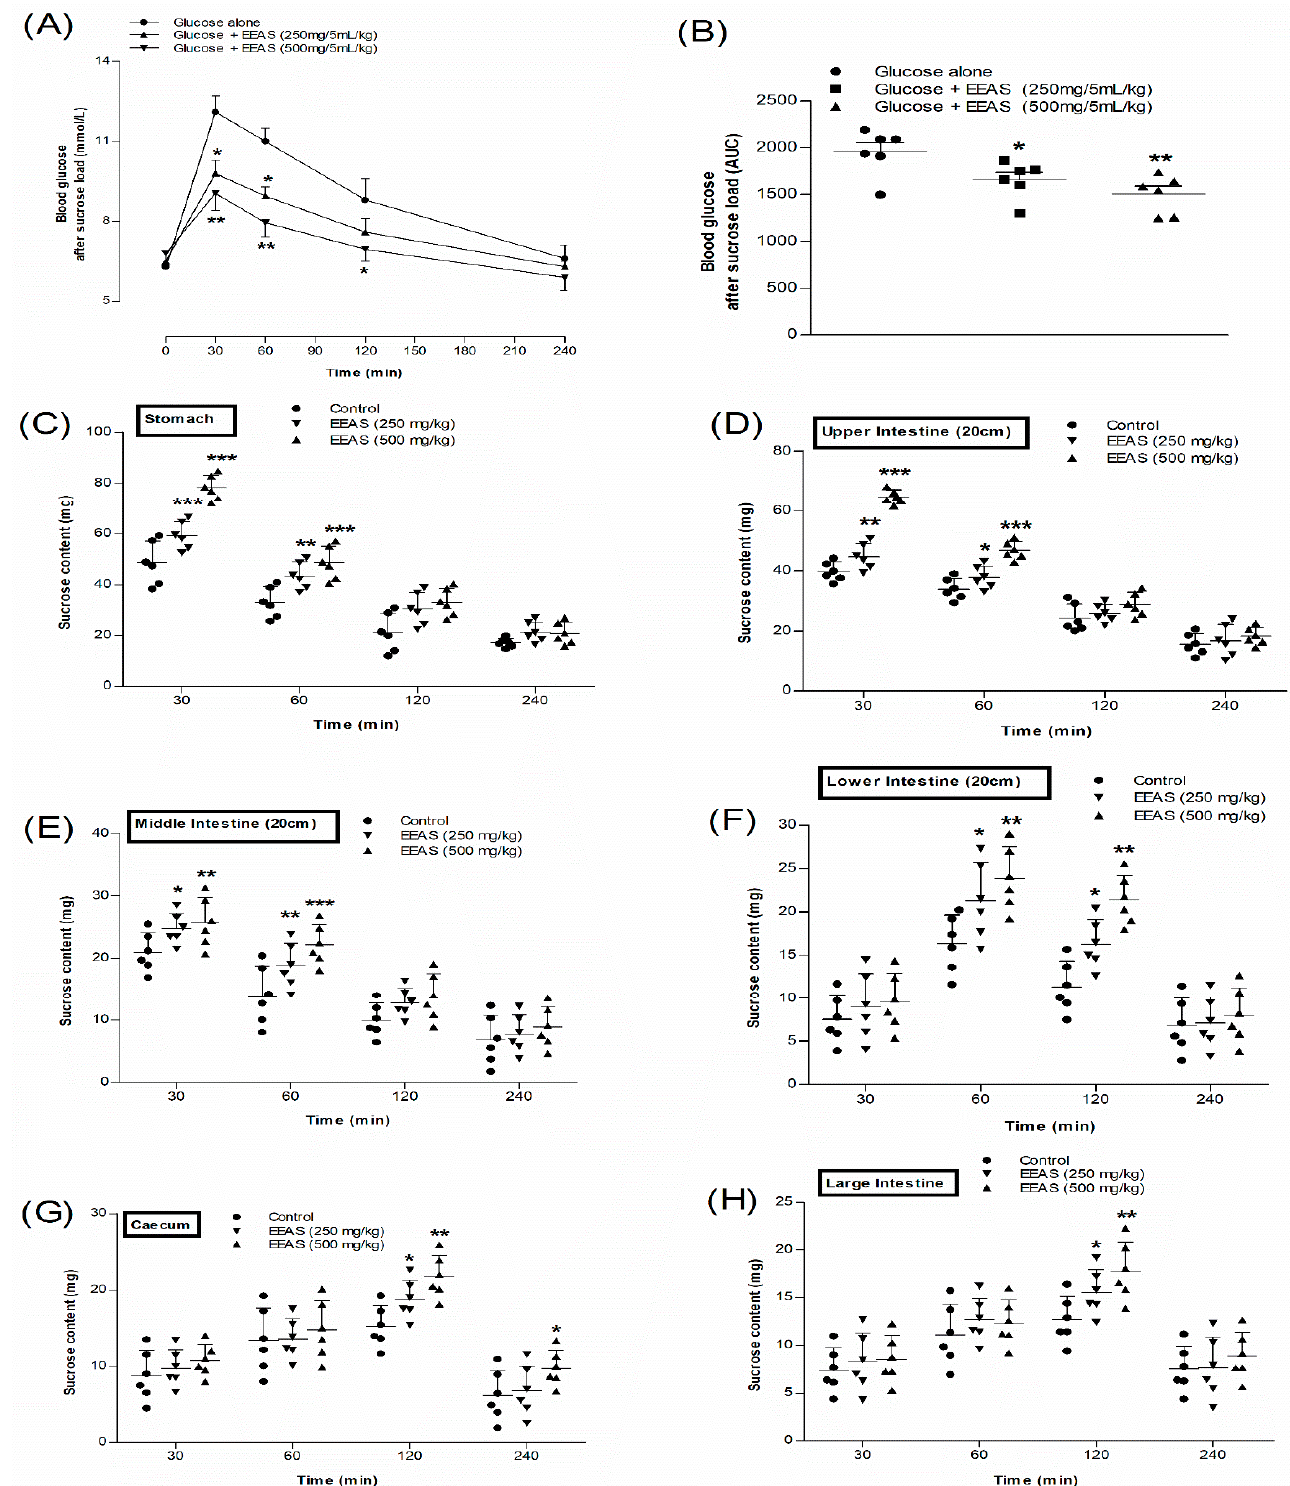
Figure 4. Effects of EEAS on ( A , B ) blood glucose after sucrose load and gastrointestinal sucrose content in ( C ) stomach, ( D ) upper, ( E ) middle, and ( F ) lower intestine, ( G ) caecum, and ( H ) large intestine after oral sucrose loading in non-diabetic rats. Rats were fasted for 20 hr prior to oral administration of a sucrose solution (2.5 g/5 mL/kg b.w.) with (treated group) or without (control group) EEAS (250 mg/5 mL/kg and 500 mg/5 mL/kg b.w.). Values n = 6 for gut sucrose content and blood glucose after sucrose load are mean ± SEM. *, **, *** p < 0.05–0.001 compared to control.